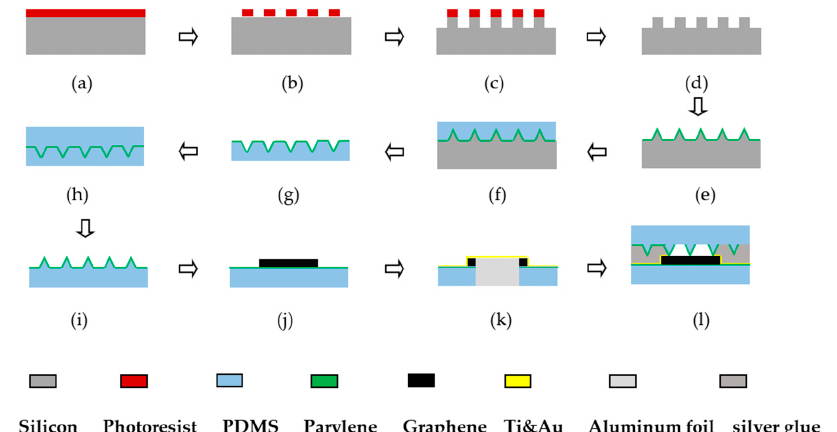
Figure 3. The flow chart for preparation process. ( a ) Spin-coating of photoresist. ( b ) Lithography. ( c ) Deep reactive ion etching. ( d ) Plasma stripping. ( e ) Depositing Parylene after wet etching. ( f ) Pouring the prepared PDMS. ( g ) Depositing Parylene after tearing off PDMS. ( h ) Pouring the configured PDMS again. ( i ) Tearing off PDMS. ( j ) Transferring graphene. ( k ) Sputtering Ti and Au. ( l ) Encapsulating after coating conductive silver glue.